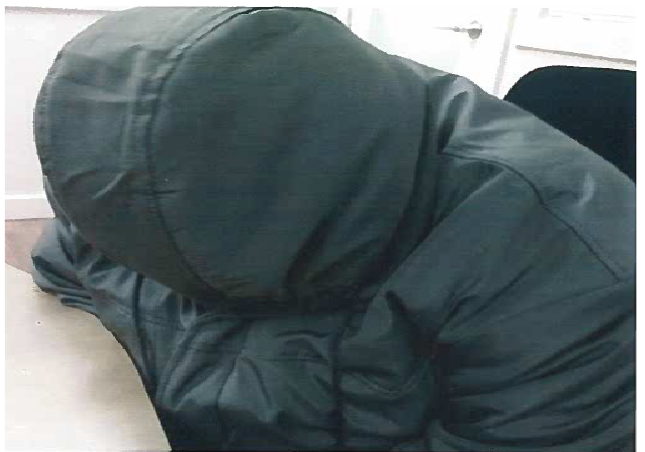
Image 2. Babsy’s